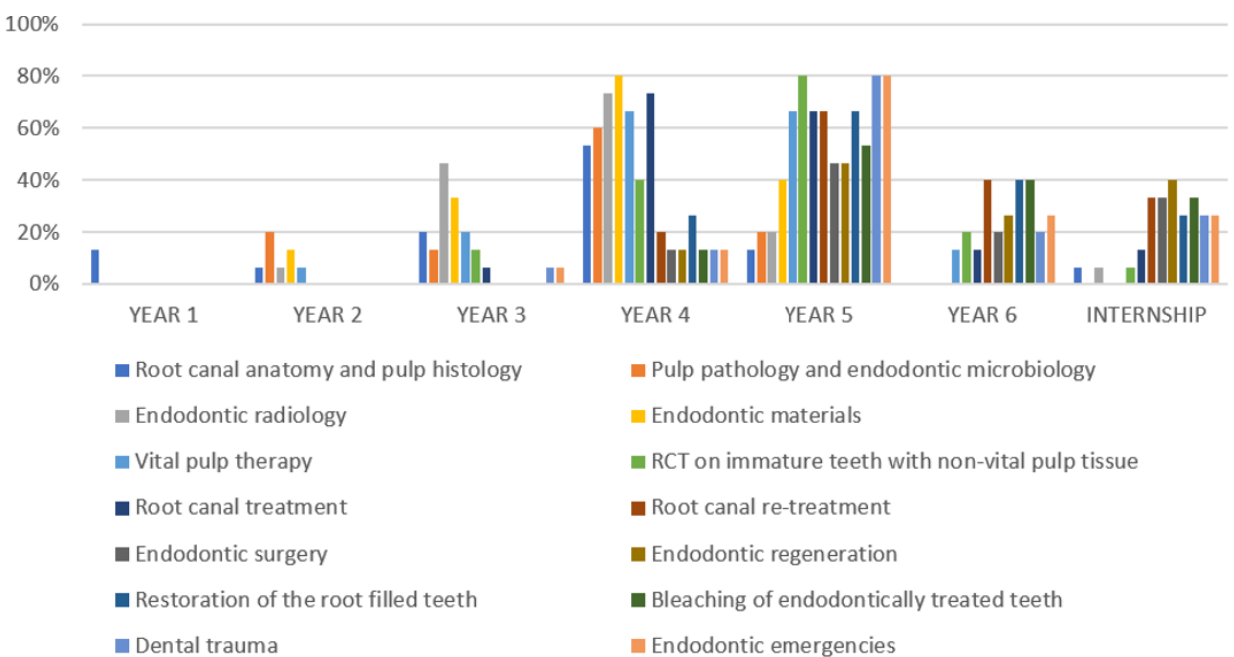
Figure 1. Yearly distribution of endodontic topics taught in Saudi Colleges.